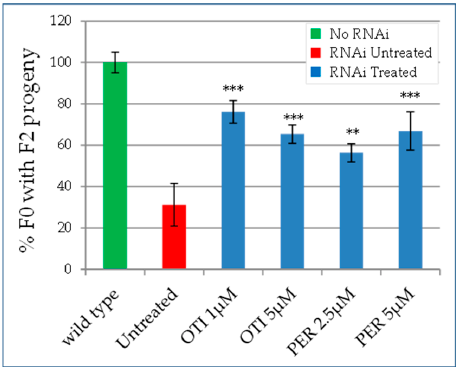
Figure 4. Rescue of embryonic lethality in C. elegans . Percentage of F0 adult worms able to give an F2 progeny. The number of F0 adult worms in 8 days treated with RNAi ant1-1 in the presence of otilonium bromide (OTI) or pergolide mesylate (PER) giving an F2 progeny (blue bars) was compared to that obtained without the addition of the drugs (red bar), where, instead, the same amount of DMSO (compound vehicle) was added. Statistical analysis was performed using Wilcoxon test comparing treated (blue bars) versus untreated mutant (red bar): ** p < 0.05; *** p < 0.001.